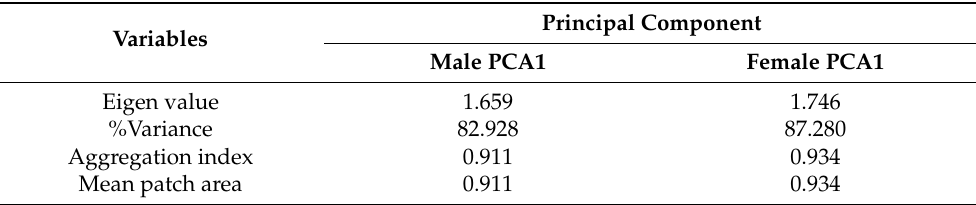
Table A2. Principal component analysis of the landscape pattern index of 95%UD of male and female Reeves’s Pheasants.